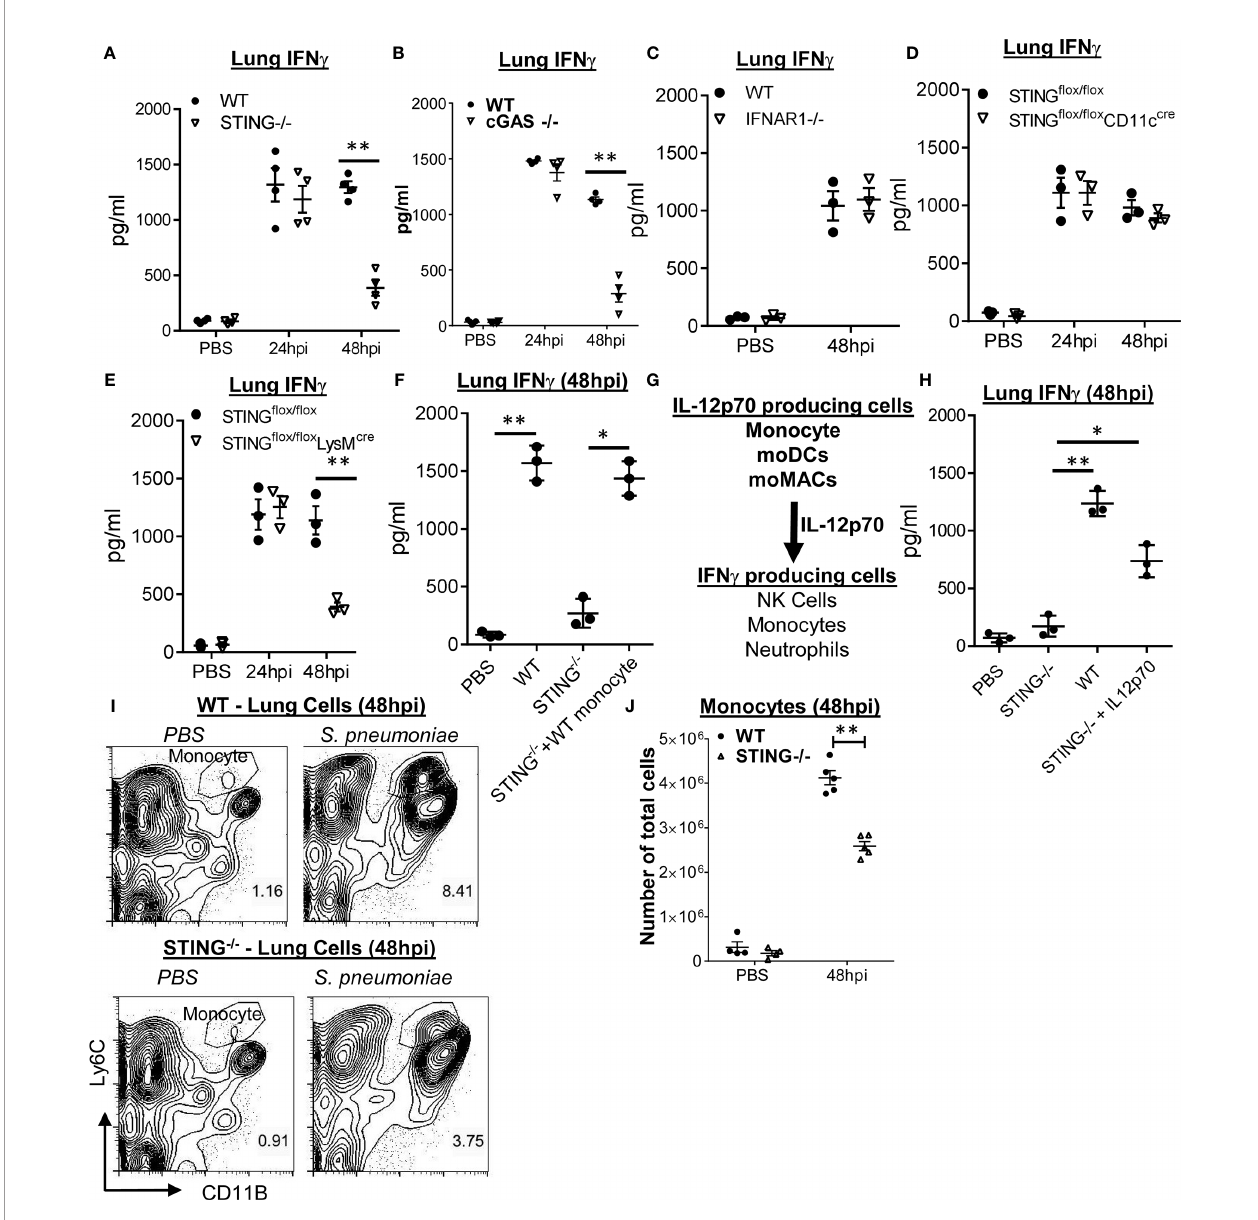
FIGURE 3 | Monocyte expression of STING mediates S. pneumoniae induced late-stage lung IFN g production. (A, B) STING − / − , cGAS − / − , and WT littermates were given PBS or infected (i.n.) with S. pneumoniae (D39 strain, ~5 × 10 6 CFU). IFN g in lung homogenates (24 and 48hpi) were measured by ELISA (n = 3 – 4 mice per group). Data are representative of two independent experiments. (C) IFNAR1 − / − and WT littermate mice were infected with S. pneunoniae as in (A) . IFN g in lung homogenates (48 hpi) were measured by ELISA (n = 3 mice per group). Data are representative of two independent experiments. (D, E) STING fl / fl CD11C Cre , STING fl / fl LysM Cre , and STING fl / fl littermates mice were infected (i.n.) with S. pneumoniae as in (A) . IFN g in lung homogenates (24, 48 hpi) were measured by ELISA (n = 3 mice per group). Data are representative of two independent experiments. (F) STING − / − and WT littermates were infected with S. pneumoniae as in panel (A) At 16 hpi, 1 million bone marrow WT Ly6C hi monocytes were adoptively transferred (i.n.) into STING − / − mice (STING − / − + WT monocyte). IFN g in lung homogenates was measured at 48 hpi by ELISA (n = 3 mice per group). Data were representative of two independent experiments. (G) A diagram of lung IFN g production by monocyte-derived IL-12p70. (H) STING − / − and WT littermates were infected with S. pneumoniae as in (A) . At the 16 hpi, recombinant IL-12p70 (1 µg) was administered (i.n.) into STING − / − mice. IFN g in lung homogenates was measured at 48 hpi by ELISA (n = 3 mice per group). Data are representative of two independent experiments. (I, J) STING − / − and WT littermates mice were infected (i.n.) with S. pneumoniae as in (A) . Ly6C hi monocytes (I) were identi fi ed in total lung cells at 48 hpi by fl ow cytometry. Total cell numbers of lung Ly6C hi monocytes (J) were enumerated (n = 3 – 4 mice per group). Data were representative of three independent experiments. Graphs represent the mean with error bars indicating SEM. p -values determined by one-way ANOVA Tukey ’ s multiple comparison test. Signi fi cance is represented by asterisk, where * p < 0.05, ** p <